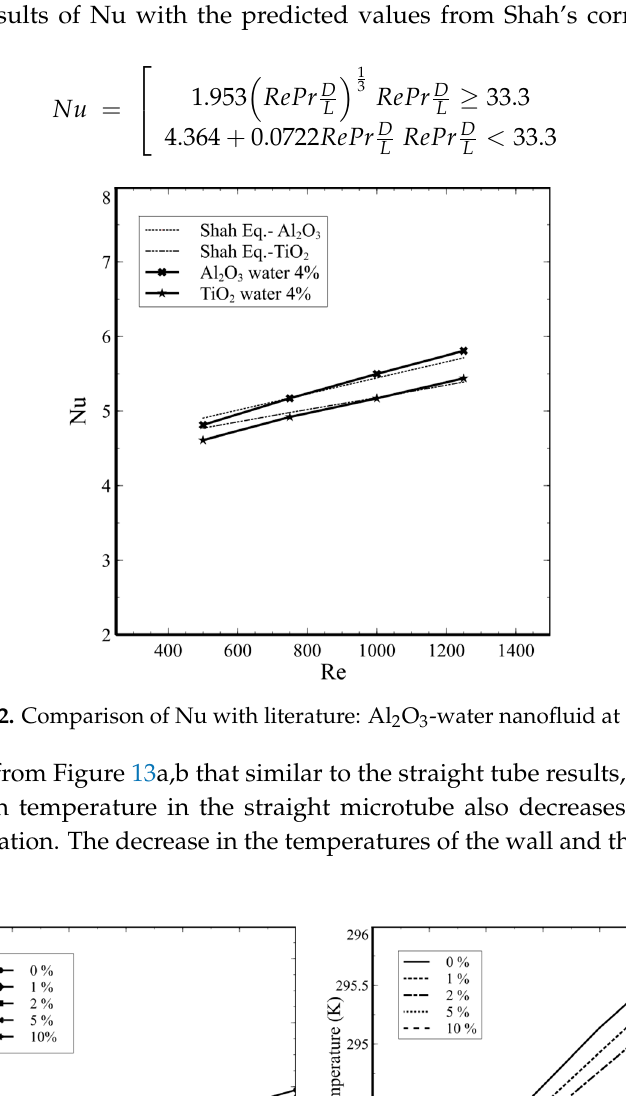
Figure 12. Comparison of Nu with literature: Al 2 O 3 -water nanofluid at 𝜙 (cid:3029) = 4%.